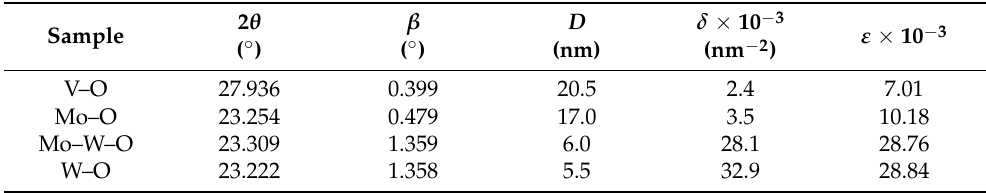
Figure 3. ( a ) XRD spectra of vanadium oxide, tungsten trioxide, molybdenum trioxide, and molybde- notungsten trioxide films. Where ( b ) summarizes the relationship between the FWHM ( β in ( ◦ )), the crystallite size ( D in (nm)), dislocation density ( δ in (nm − 2 )), microstrain ( ε in (unitless) of each layer. Table 2. Shows the main peak position, corresponding FWHM, crystallite size, dislocation density, and microstrain of the